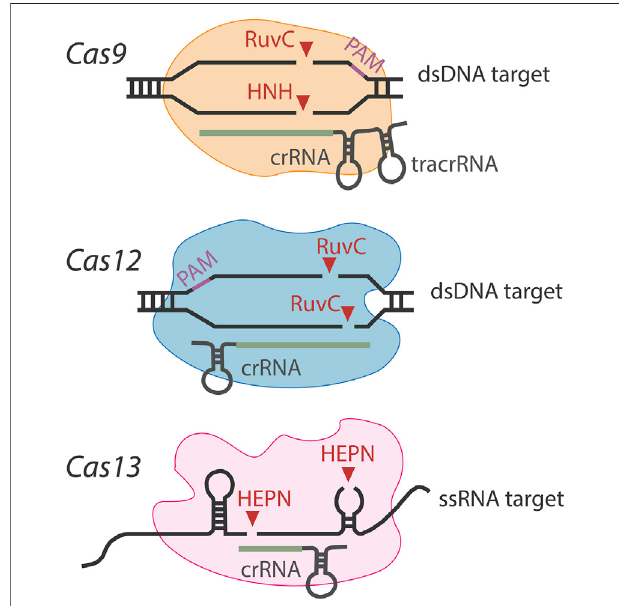
FIGURE 1 | Diagrams of Cas9, Cas12, and Cas13